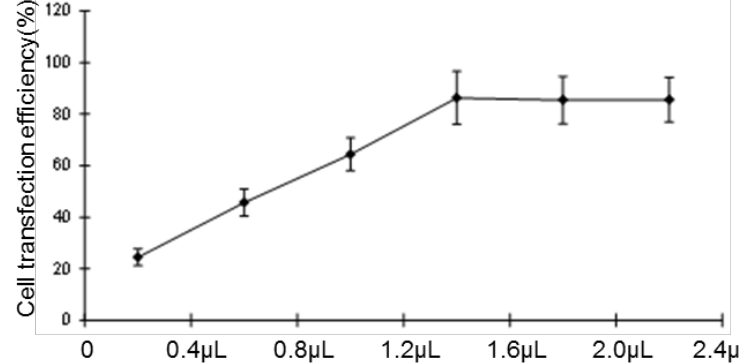
Figure 2. The transient transfection rate of the HCCLM6 cell line.